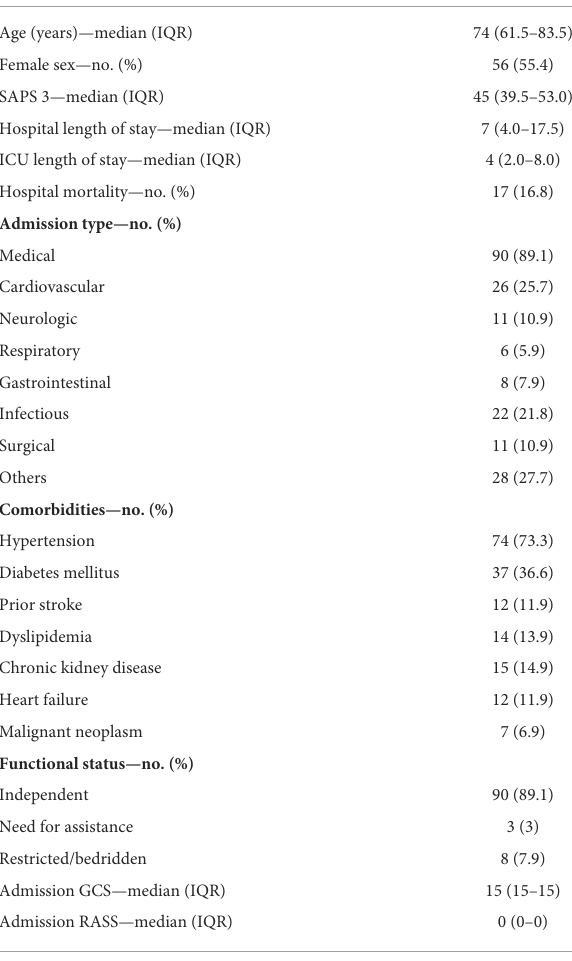
TABLE 1 Population clinical characteristics.